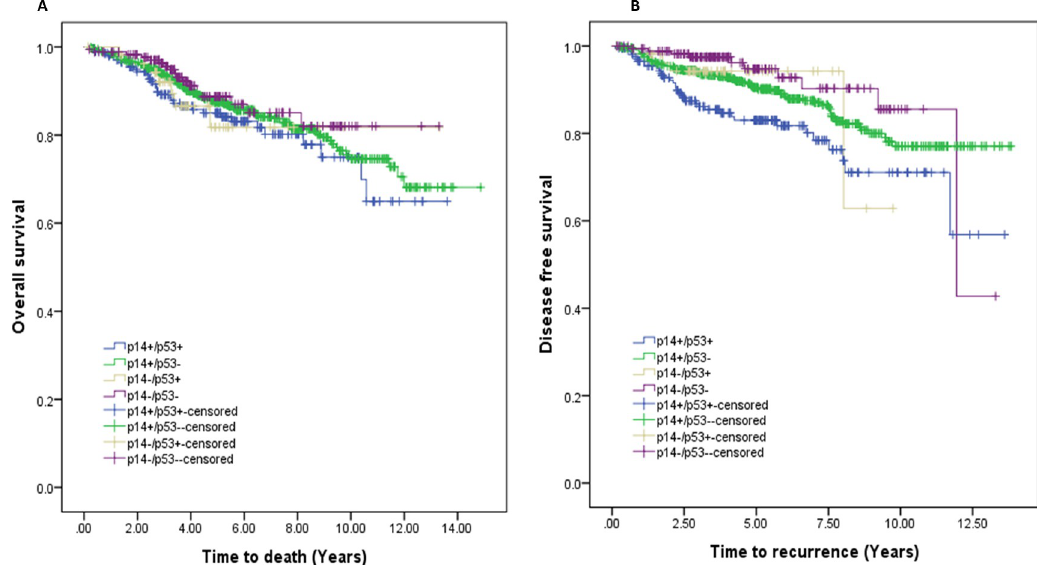
Fig 3. Survival probability based on joint effect of P14 and P53 expression. A: Overall survival, no significant difference was seen between each combination B: Disease free survival probability based on joint effect of P14 and P53 expression. P14+/P53 + VS. P14-/P53- (p = 0.001) and P14+/P53+ vs. P14+/P53- (p = 0.007) showed significant differences in DFS. The worst outcome was seen in patients with P14+/P53+ tumours.